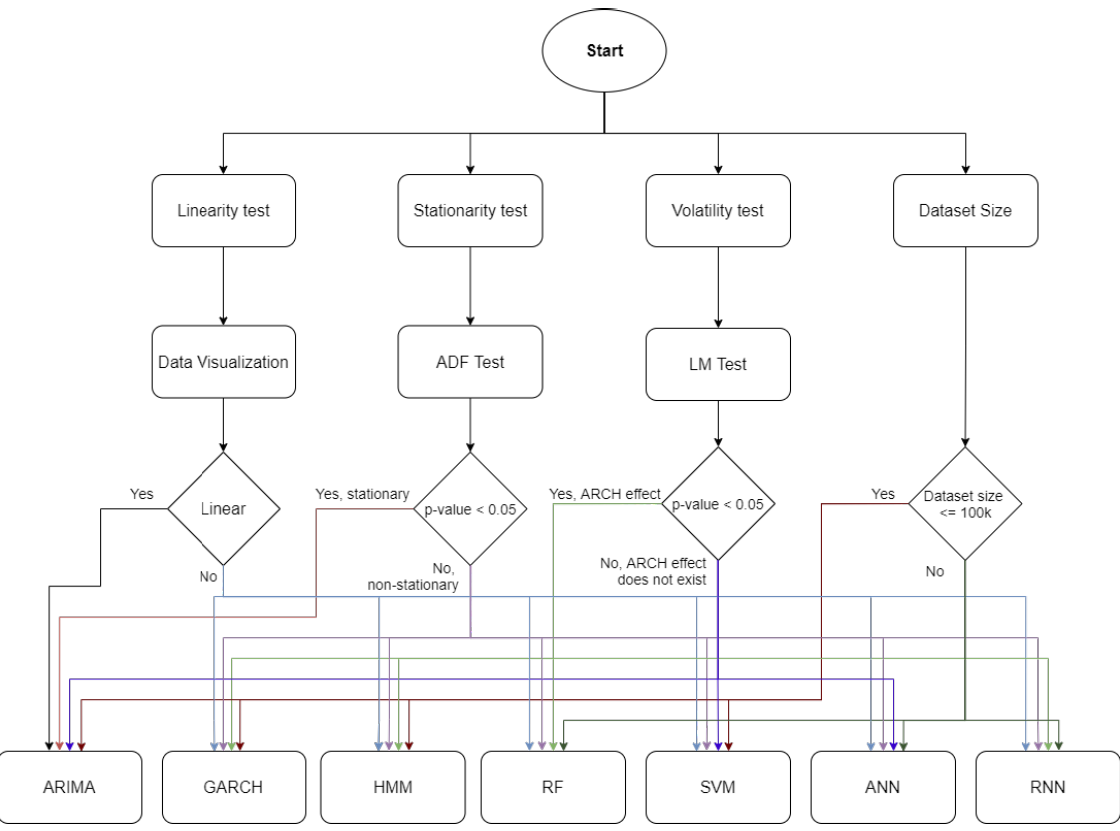
Figure 9. Proposed framework for optimal model selection.